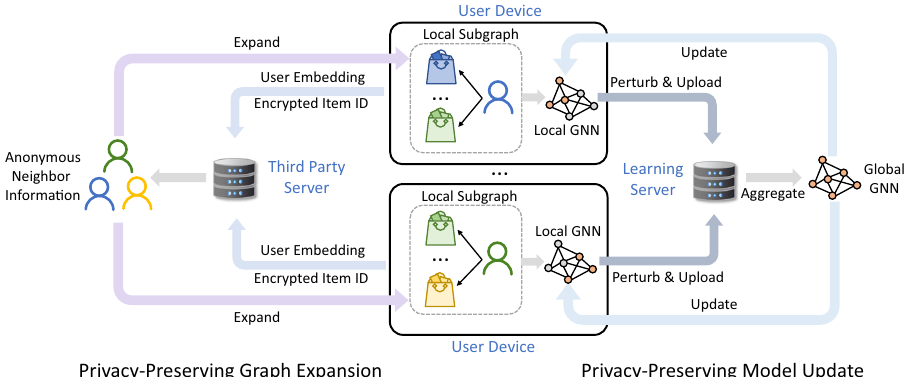
Fig. 1 The overall framework of FedPerGNN. Each user device learns a local GNN model based on the local subgraph inferred from the local user data. A learning server is used to coordinate a large number of user devices for learning the global GNN model collaboratively. A privacy-preserving model update method is used to protect private user information encoded in the model gradients exchanged among the learning server and clients. A third-party server is used to conduct the privacy-preserving graph expansion protocol to incorporate high-order graph information into local model learning under privacy protection. The devices upload the user embedding and encrypted item IDs to this server for fi nding user neighbors, and the embeddings of anonymous neighbor users are distributed to user devices for expanding Table 1 Performance of different methods in terms of RMSE. Methods